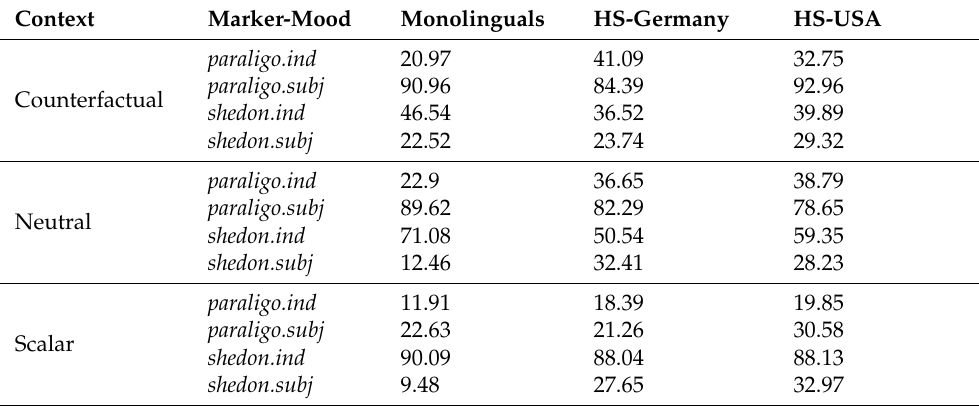
Figure 4. The figure shows Responses to sentences in the study grouped into boxplots by Context and Marker+Mood (subsumed under Condition) variables. Each subplot shows the results for one participant group as indicated by the title at the top of each subplot. The responses in form of ratings are illustrated by points and errorbars. Table 7. Mean rating per context and condition in the three